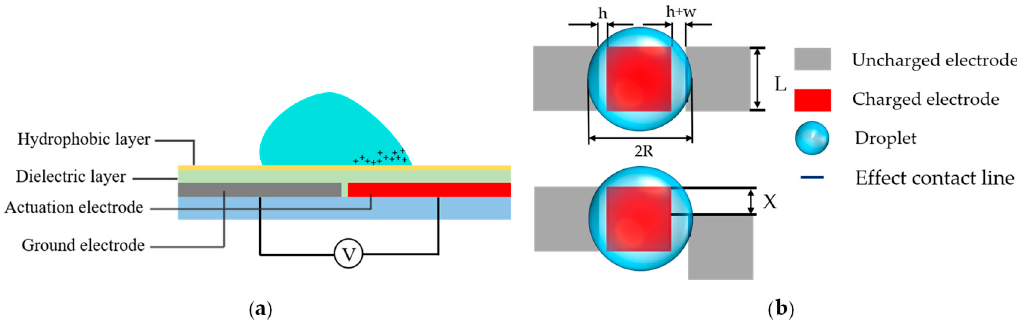
Figure 1. ( a ) Schematic diagram of driving a droplet on an open electrowetting-on-dielectric (EWOD) chip; ( b ) Schematic diagram of the effective contact line of a droplet when the electrode is normal and misaligned.